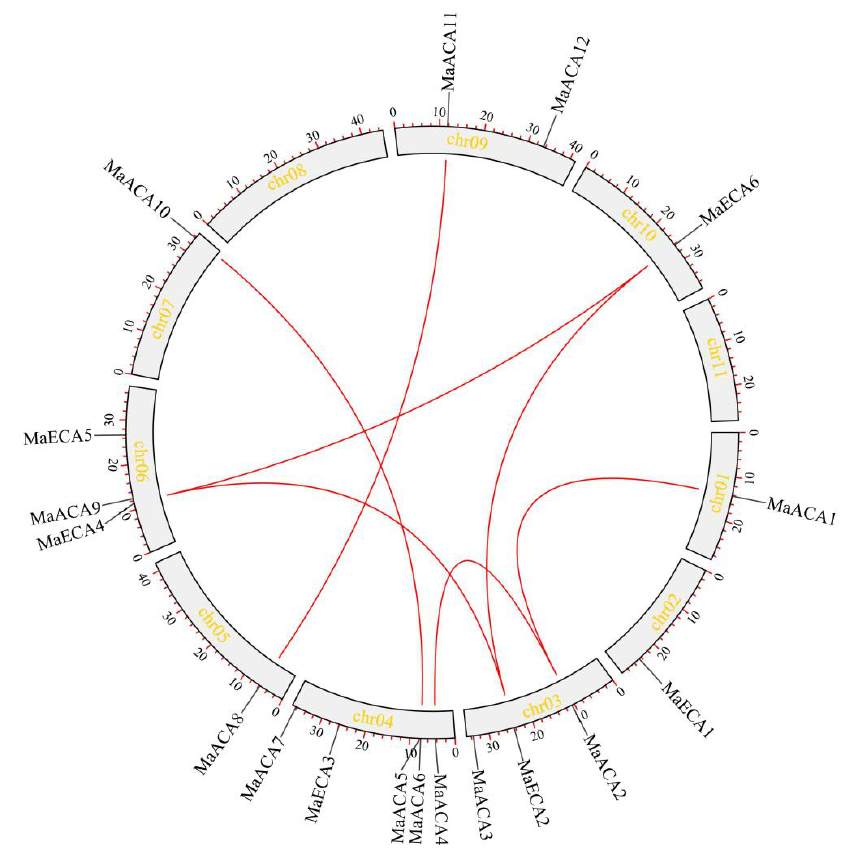
Figure 1. Chromosome localization and collinear relationship of banana Ca 2+ -ATPase genes. The red line indicates the segmental duplication gene pairs. line indicates the segmental duplication gene